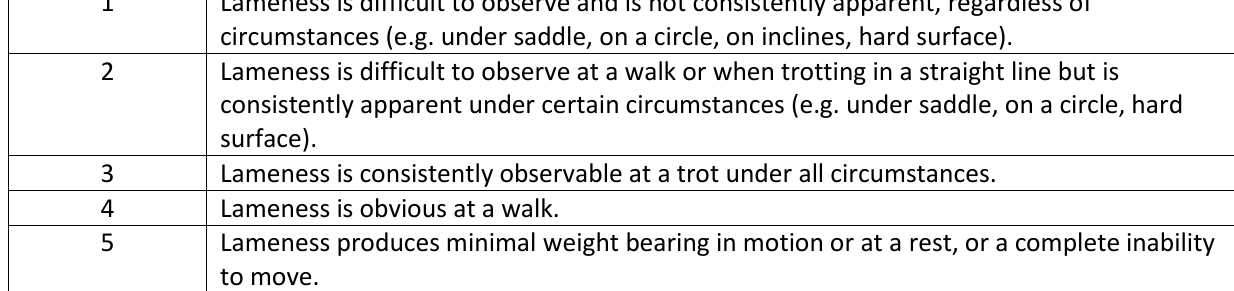
Table 2: A description of the AAEP lameness scoring